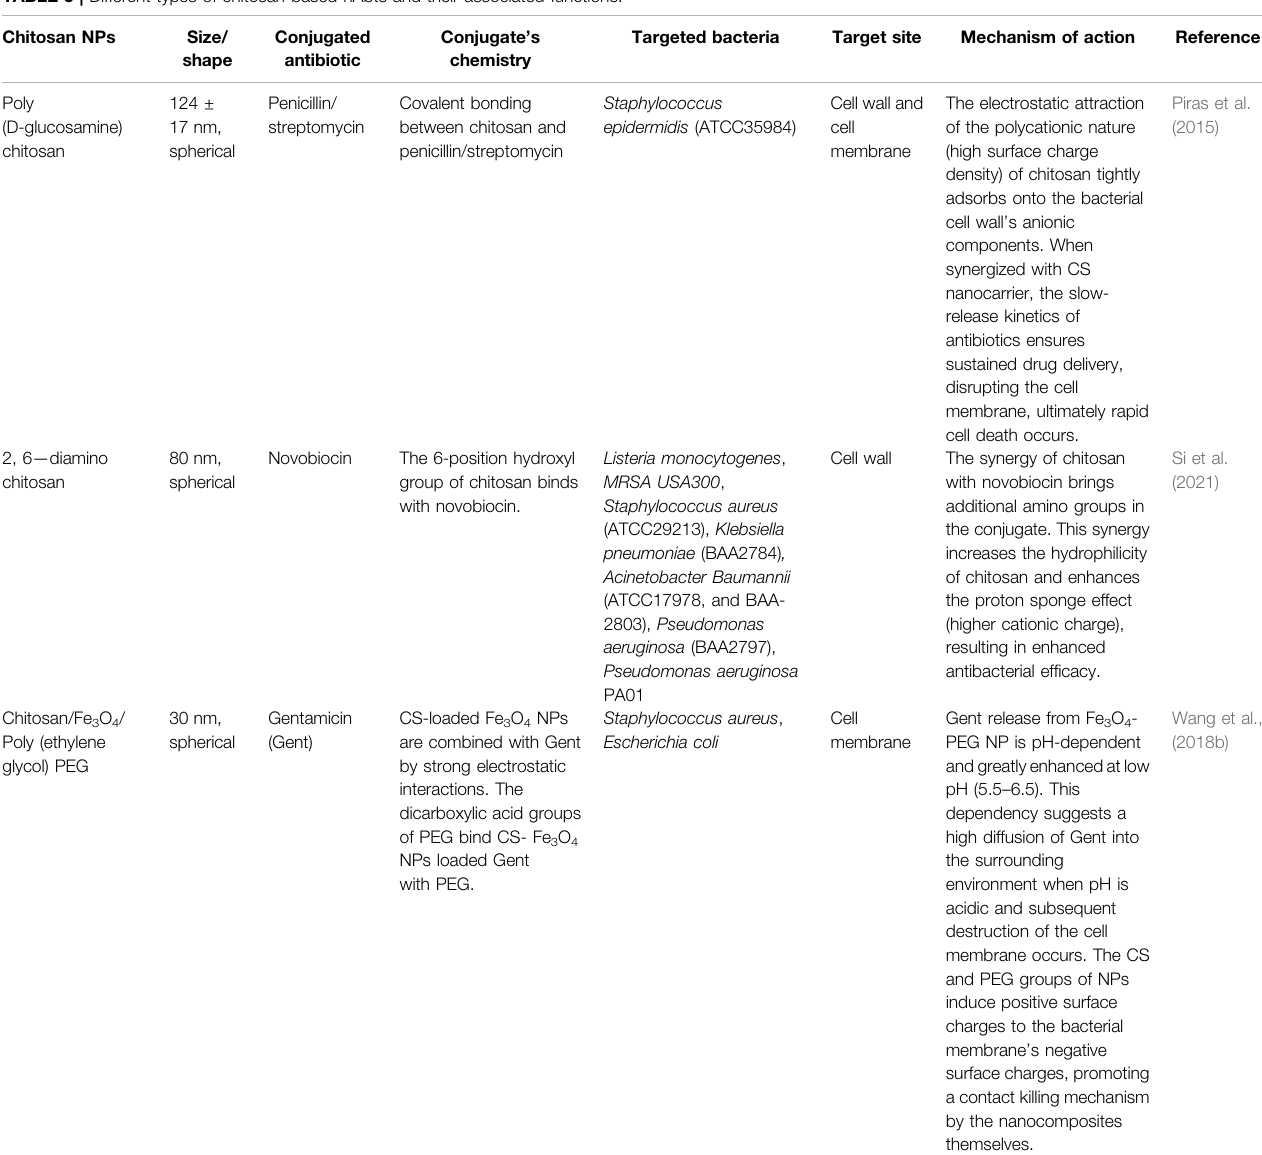
TABLE 5 | Different types of chitosan-based nAbts and their associated functions. Chitosan